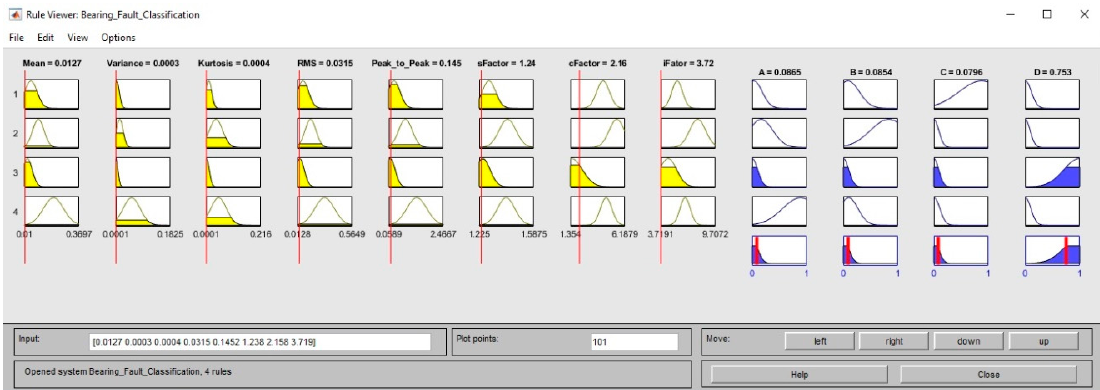
Figure 11. Fuzzy rule inferencing system for bearing fault classification.